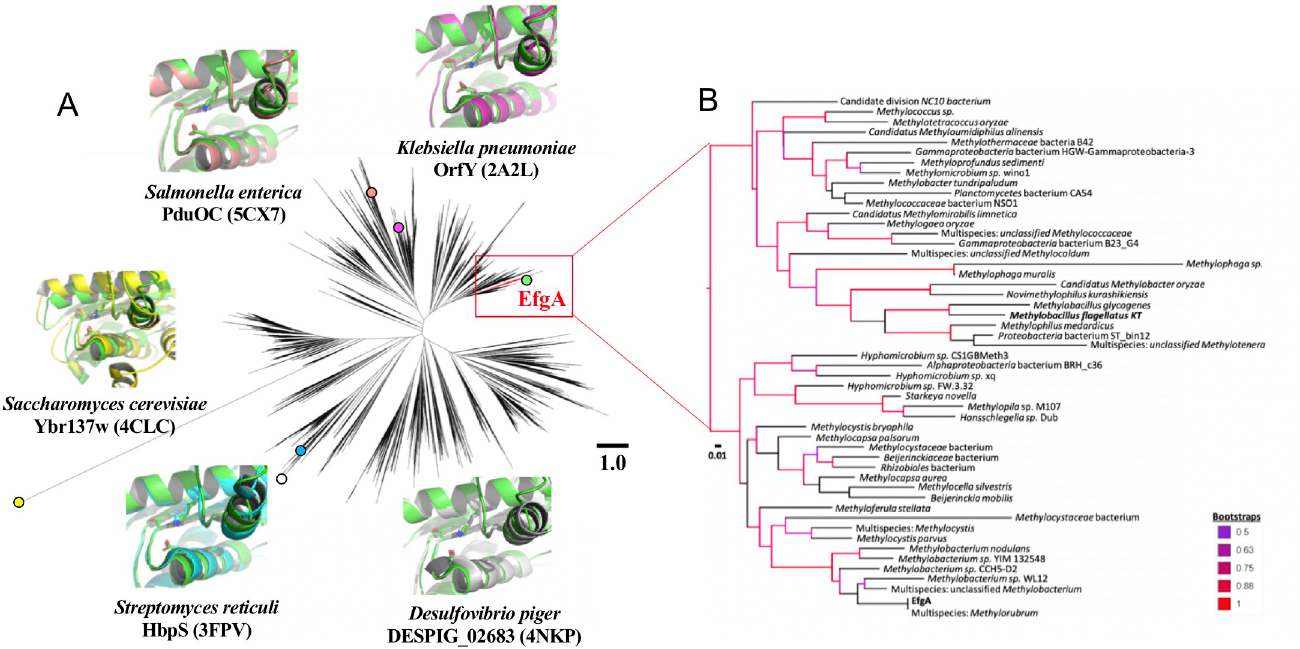
Fig 2. Phylogenetic analysis of the DUF336 superfamily indicates close homologs to EfgA are present in a broad array of methylotrophs. (A) The evolutionary relationship of the DUF336 region was compared to all current amino acid sequences and structures currently on NCBI via maximum likelihood. Solved structures of EfgA homologs are represented on the tree with their respective PDB accession codes and overlaid onto EfgA structure (green). The red colored sequences represent members of the EfgA clade. (B) Expanded view of the EfgA clade with bootstrap values above 50 highlighted by color according to the key. Bolded names indicate experimentally verified EfgA-like function. Scale bars for both (A) and (B) indicate substitutions per residue. The phylogenetic data are available at TreeBASE (http://purl.org/phylo/treebase/phylows/study/TB2:S27073).